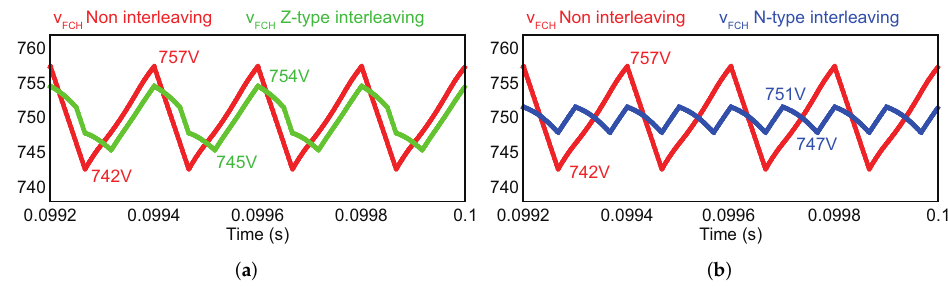
Figure 18. ( a ) Capacitor voltage for Z-type interleaving; ( b ) capacitor voltage for N-type interleaving.